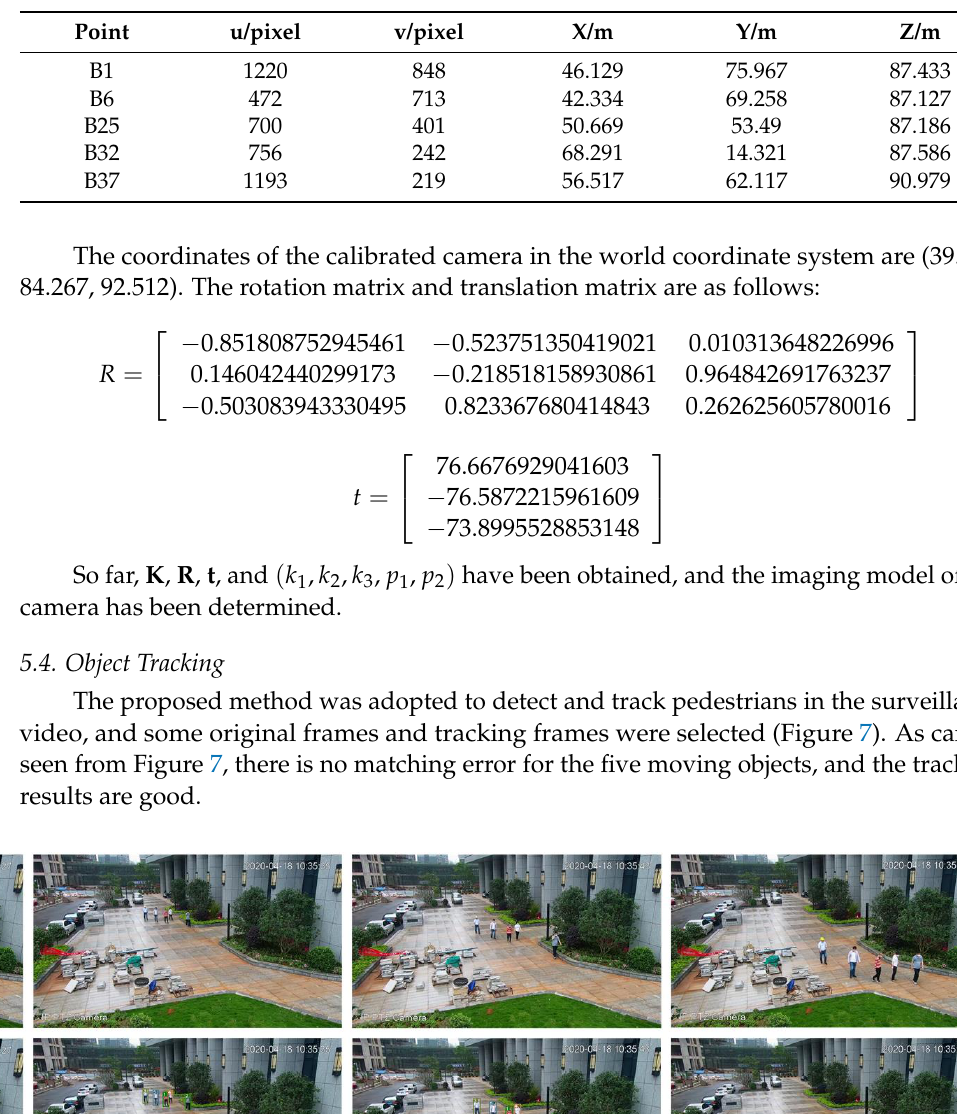
Table 1. Point pairs corresponding to image coordinates and world coordinates.